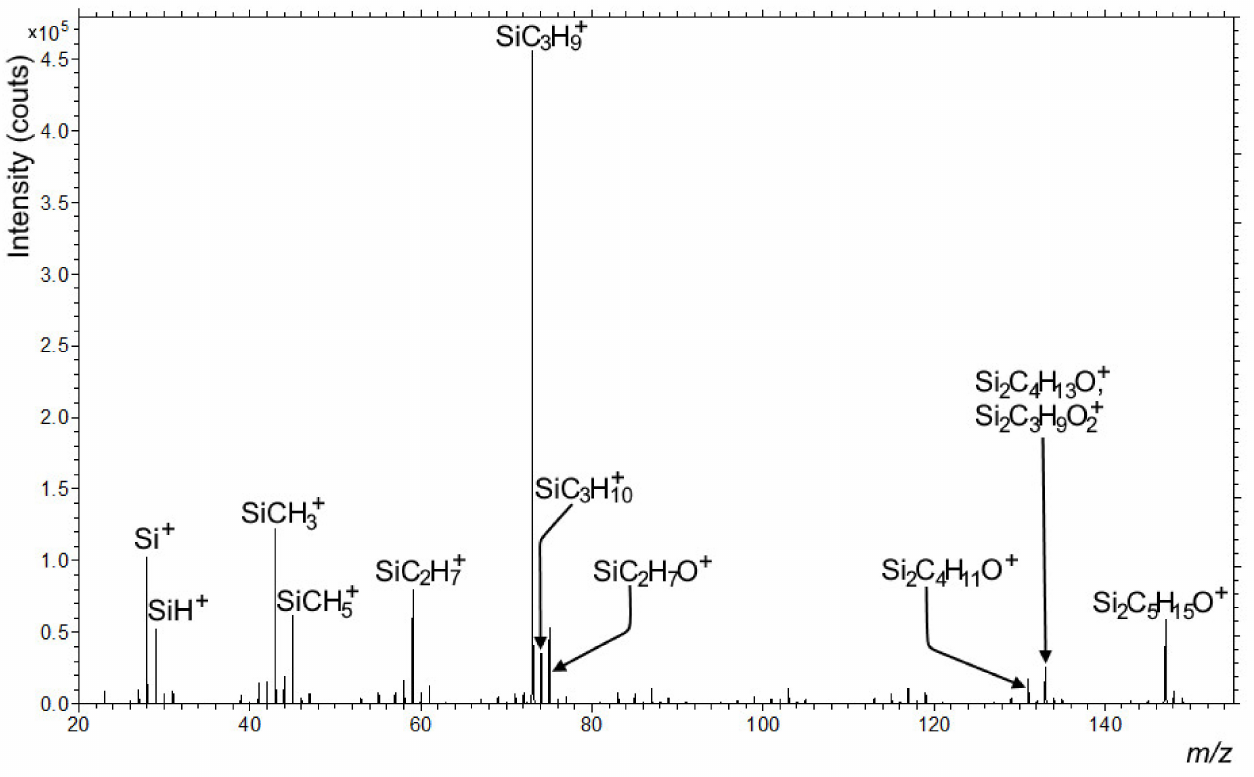
Figure 9. Positive secondary ion spectrum of the paper 1 coated with HMDSO in laboratory plasma reactor in the m/z range from 20 to 155.